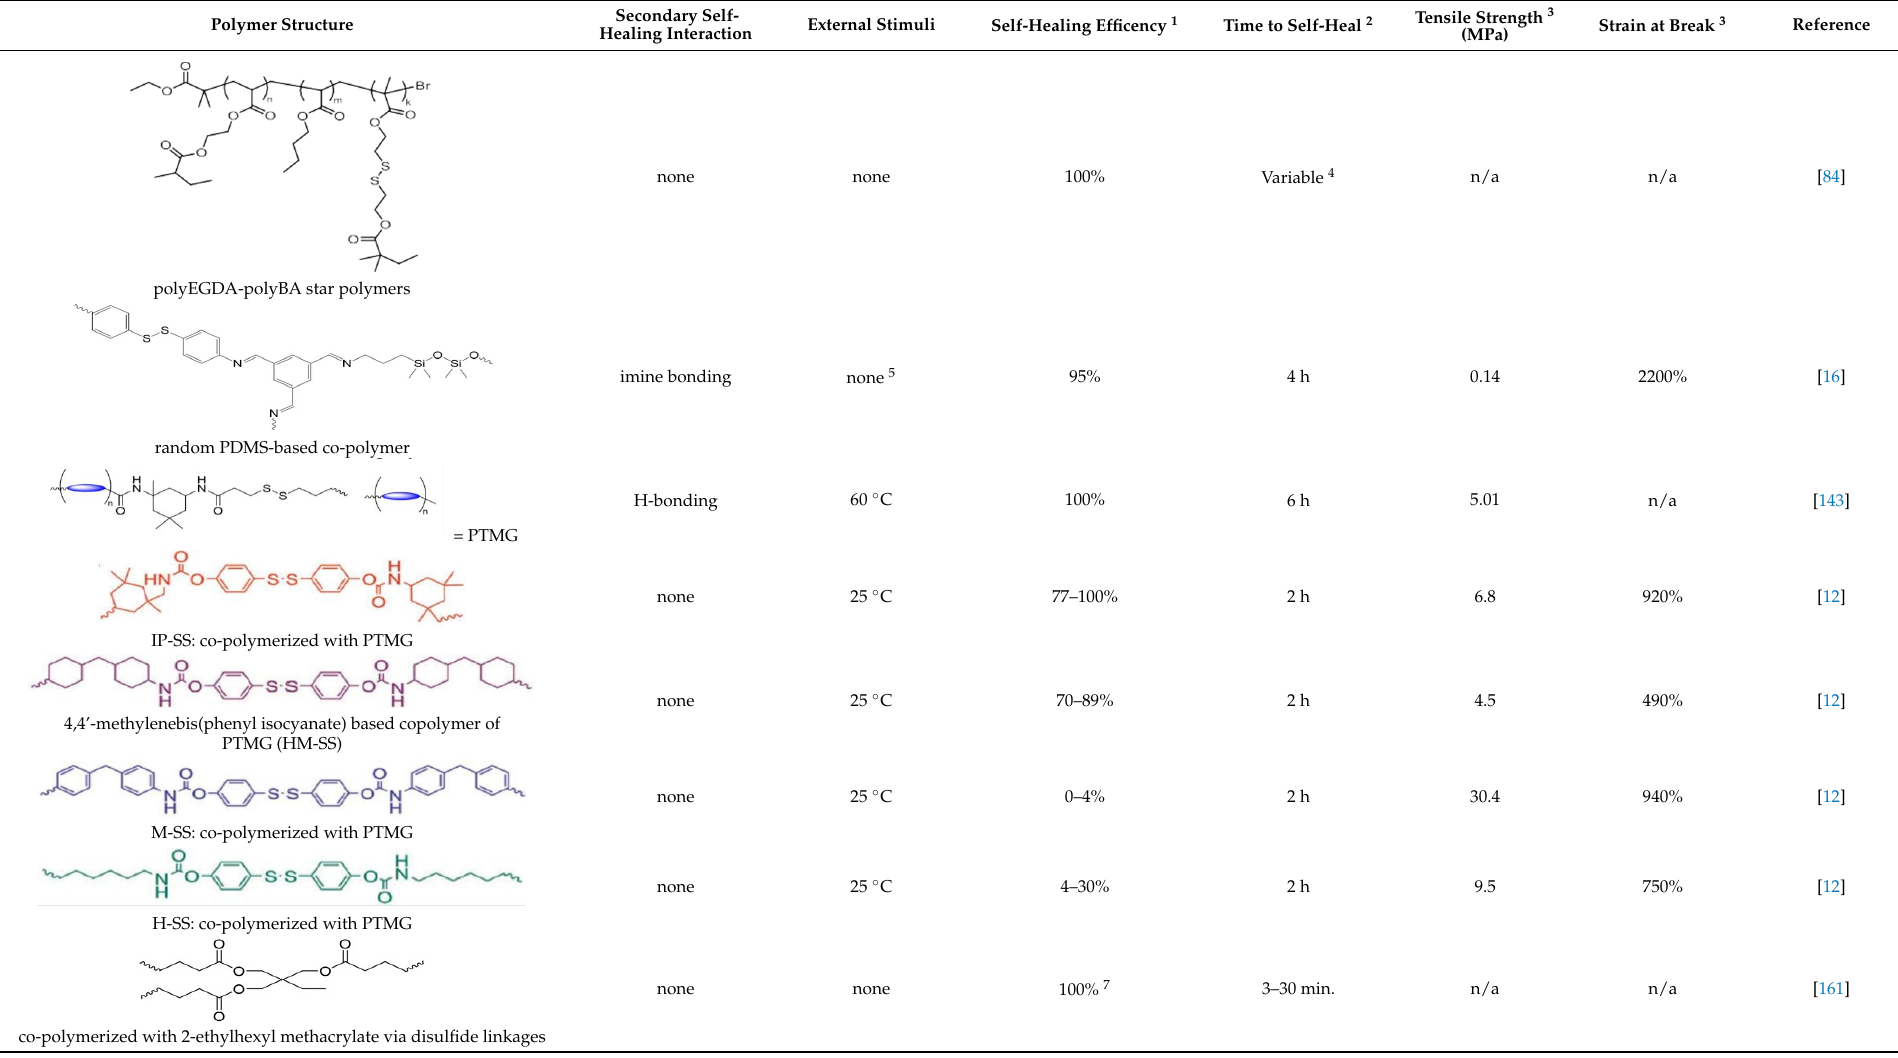
Table 2. Self-Healing Polymers Incorporating Disulfide Linkages.